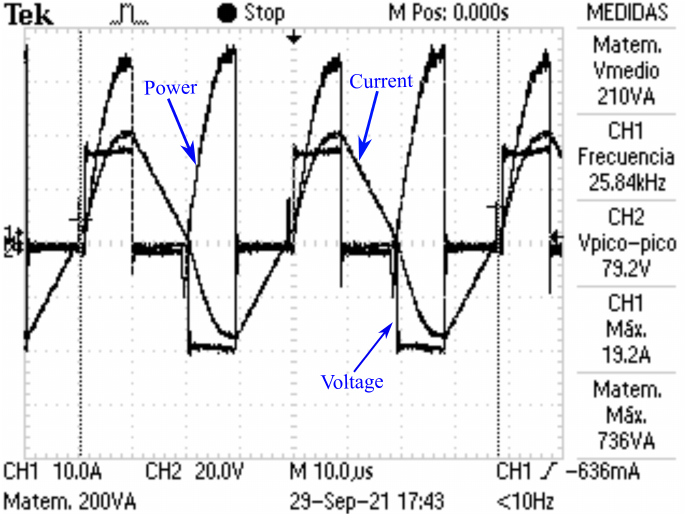
Figure 18. Illustration of the prototype